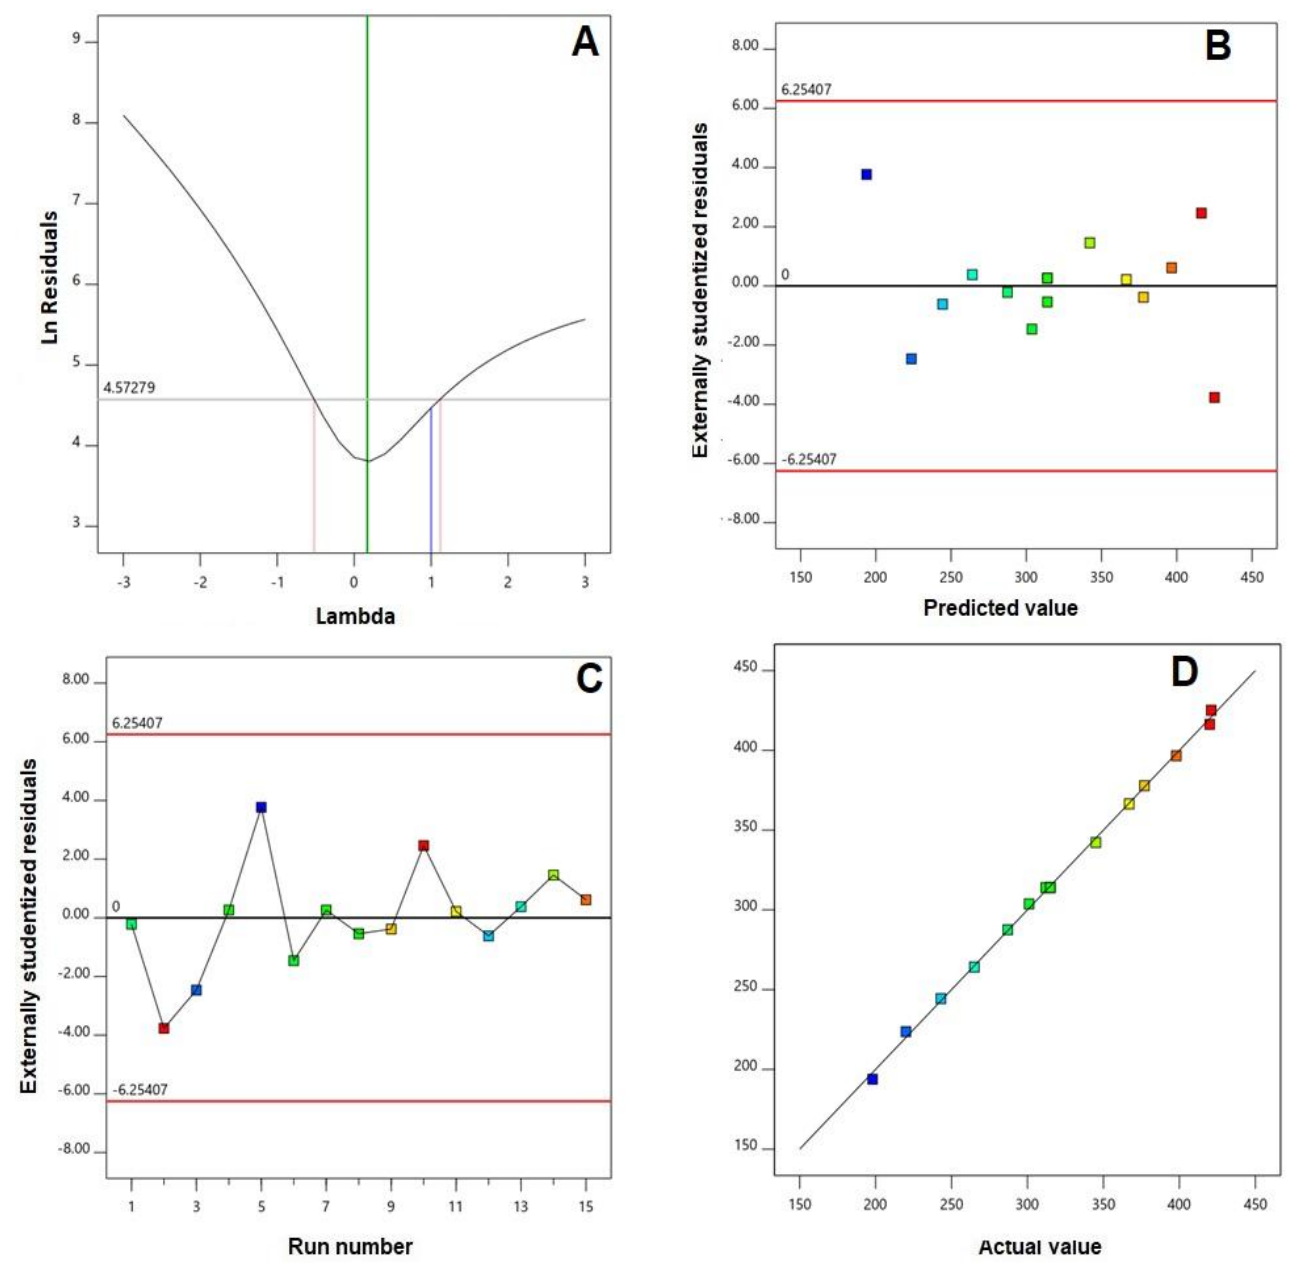
Figure 1. Diagnostic plots for the particle sizes of CTD GNE. ( A ) Box-Cox plot for power transforms, ( B ) externally studentized residuals vs. predicted values, ( C ) externally studentized residuals vs. run number, and ( D ) predicted vs. actual values plot.